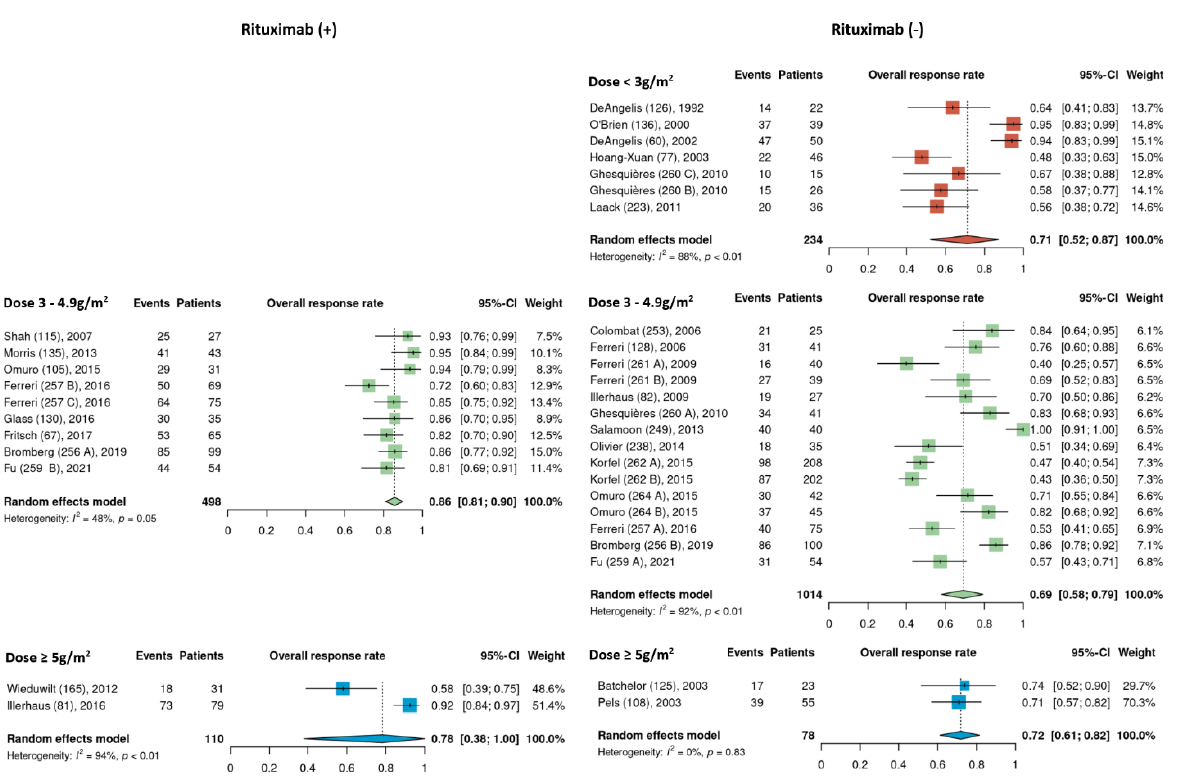
Figure 4. Exploratory comparison of overall response rates between cohorts that did and did not receive rituximab among the different HDMTX dose categories [12,14,15,18,21 – 42].